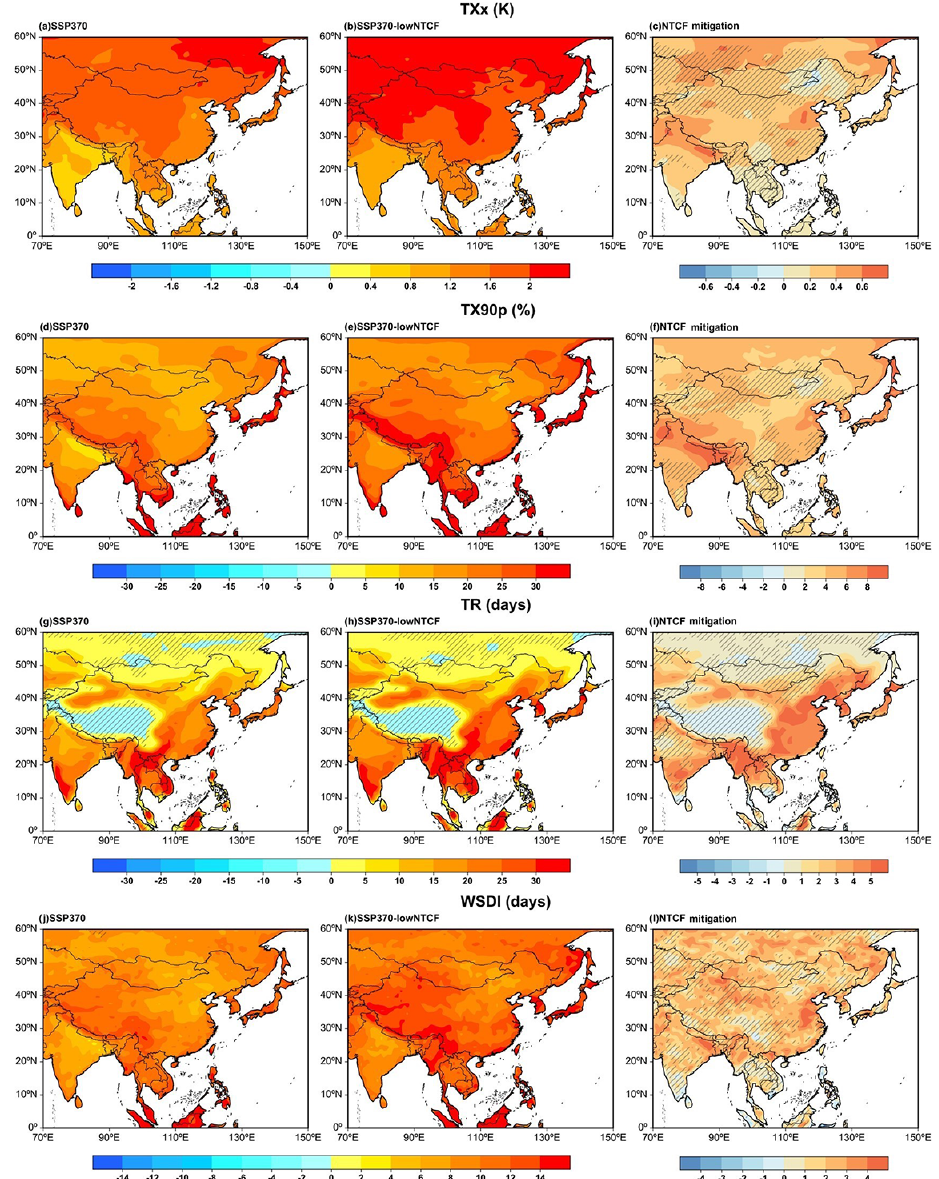
Figure 7. Spatial patterns of changes for the hottest day (TXx; a–c ), warm days (TX90p; d–f ), tropical nights (TR; g–i ), and warm-spell duration (WSDI; j–l ) during 2031–2050 in Asia under the SSP3-7.0 (left column) and SSP3-7.0-lowNTCF (middle column) scenarios relative to 1995–2014. The right column represents changes caused by the non-methane SLCF mitigation. The areas with hatching indicate that at least one out of five models disagrees on the